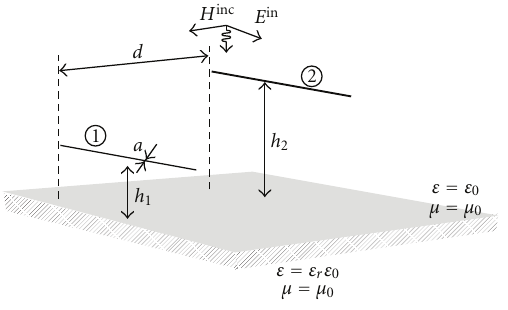
Figure 14: Geometry No. 2: Two-wire array above a dielectric half- space ( ε r = 10, a = 2cm, L = 10m, d = 1m, h 1 = 1m, and h 2 = 2m).